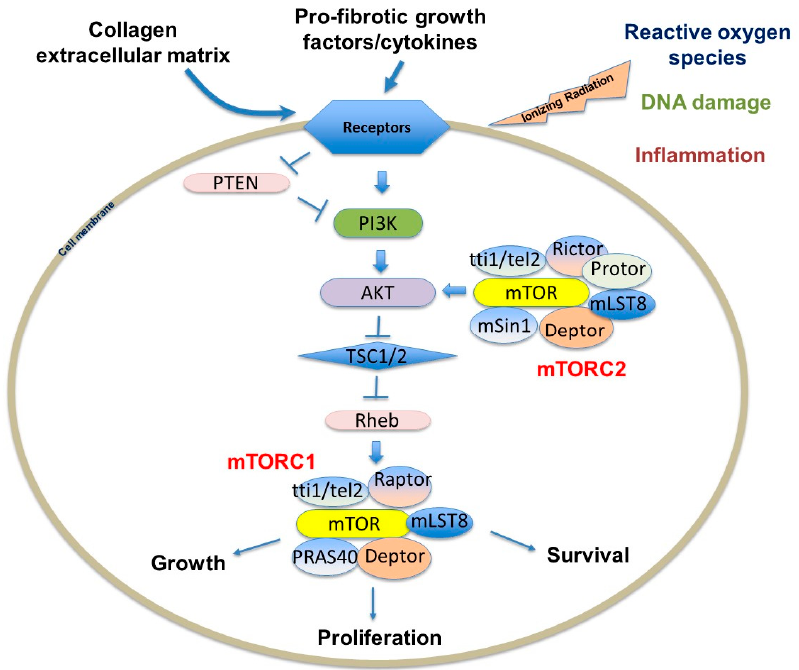
Figure 3. mTORC1 and mTORC2 complexes and environmental signals to regulate the PI3K/AKT/mTOR pathway to influence growth, proliferation and survival. T indicates the inhibition of the target